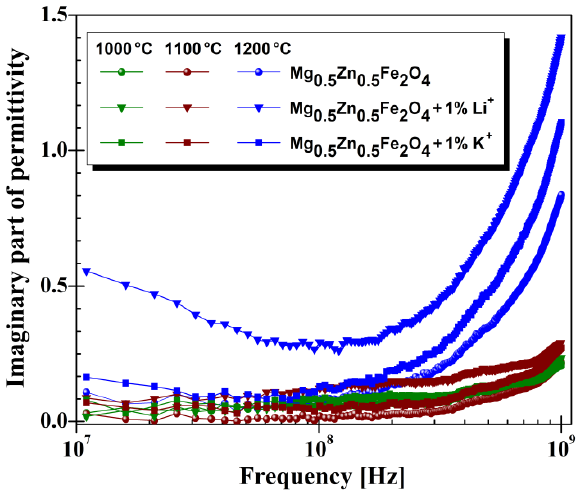
Figure 7. High-frequency characteristics of real part of permittivity for investigated Mg-Zn ferrite.